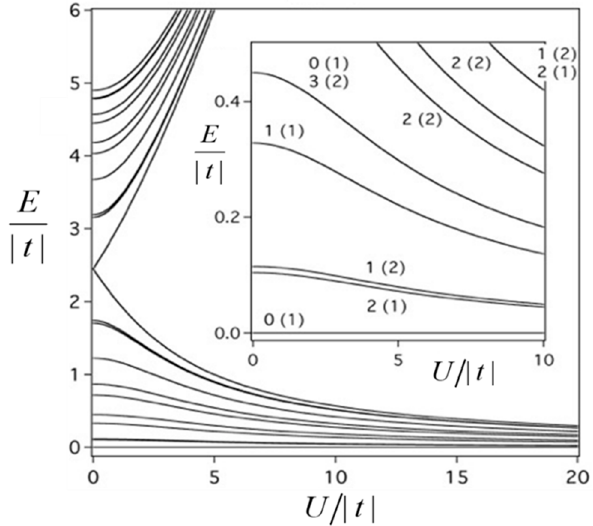
Figure 3. Combined effect of double exchange and Coulomb interaction on the energy spectrum of square-planar d 2 − d 2 − d 1 − d 1 – tetramer. The low-lying part of the energy spectrum with labelling of the energy levels is shown as insert. The energy levels are labelled as S ( f ), where S is the total spin of the tetramer and f is multiplicity of the repeated levels with the same S . The energy of the ground state is regarded as a reference energy.